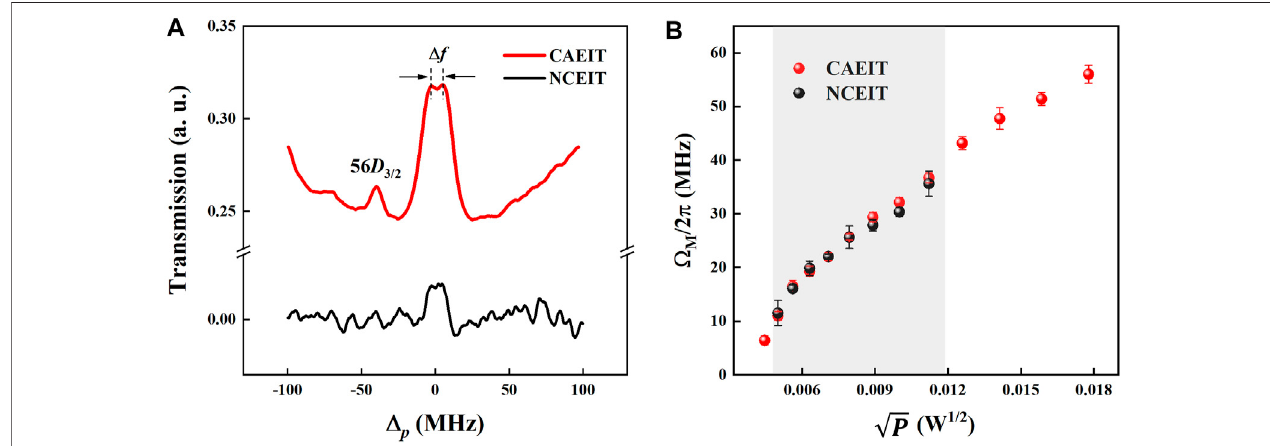
(cid:1)(cid:1) √ ) is 0.0045 W 1/2 . Δ f is the AT splitting interval of CAEIT. (B) AT P